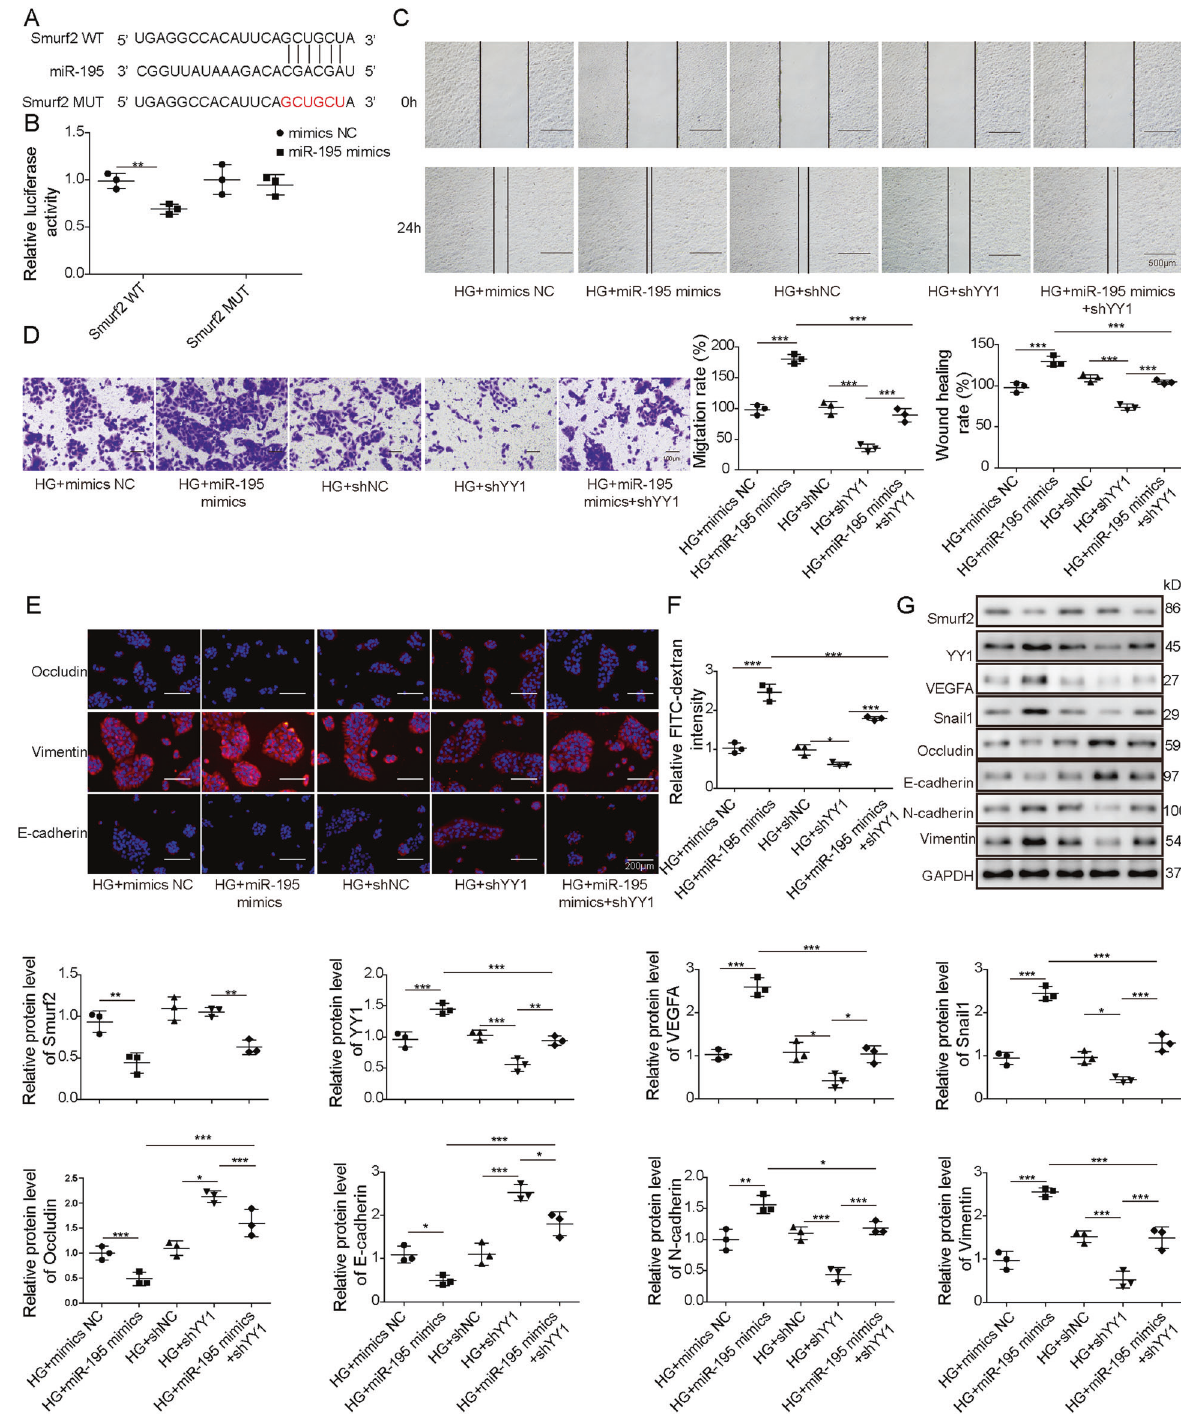
Fig. 6 MiR-195 targets Smurf2 to upregulate expression of YY1, VEGFA, and Snail1, and promote HG-induced EMT and cell permeability of ARPE-19 cells. A The target sites of miR-195 on Smurf2 were predicted via StarBase. B Luciferase activity was detected in ARPE-19 cells co- transfected with mimics NC or miR-195 mimics and Smurf2 WT or Smurf2 Mut. ARPE-19 cells were transfected with mimics NC, miR-195 mimics, shNC, shYY1, or miR-195 mimics + shYY1 before treatment of HG. C , D Cell migration was detected via wound-healing analysis and transwell assay in the treated cells. E Occludin, E-cadherin, and Vimentin levels were detected via immuno fl uorescence in the treated cells. F Cell permeability was investigated using FITC-dextran analysis in the treated cells. G Smurf2, YY1, VEGFA, Snail1, Occludin, E-cadherin, N-cadherin, and Vimentin levels were measured by western blotting in the treated cells. For each analysis, three technical replicates were performed and three biologically independently performed replicates are included, * p < 0.05, ** p < 0.01, *** p < 0.001.